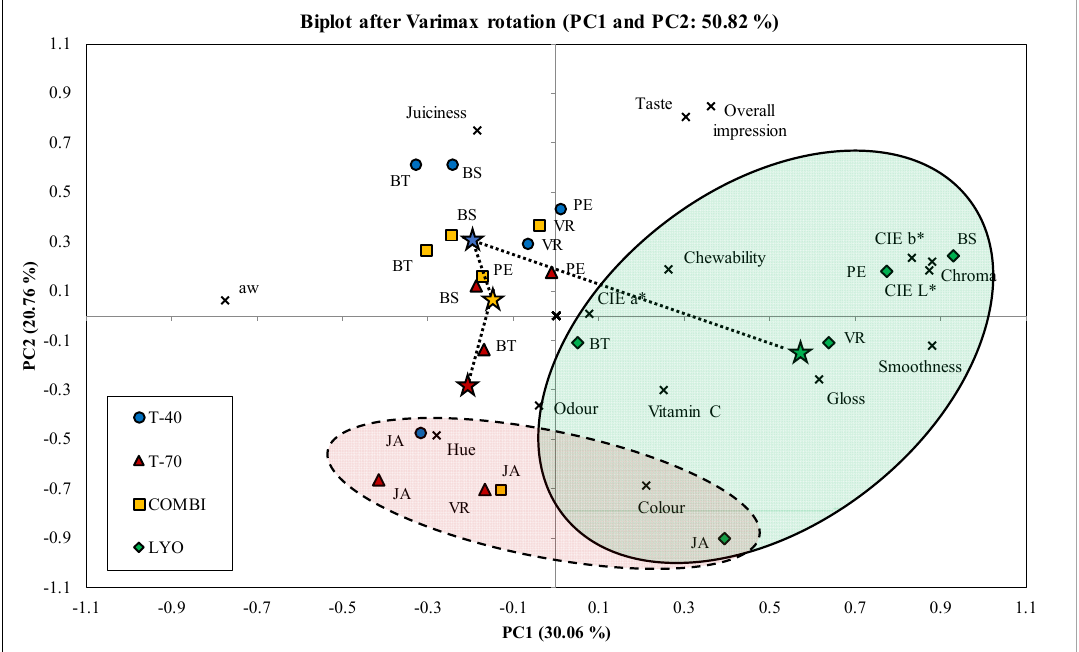
Figure 5. Principal component analysis biplot for the analysed attributes (marked with “X”) and samples (JA — Jakubské, BT — Beauty seedless, PE — Perlette, VR — Vrboska, BS — Bezsemenné) considering drying methods (T-40—40 ◦ C, T-70—70 ◦ C, COMBI—combined,